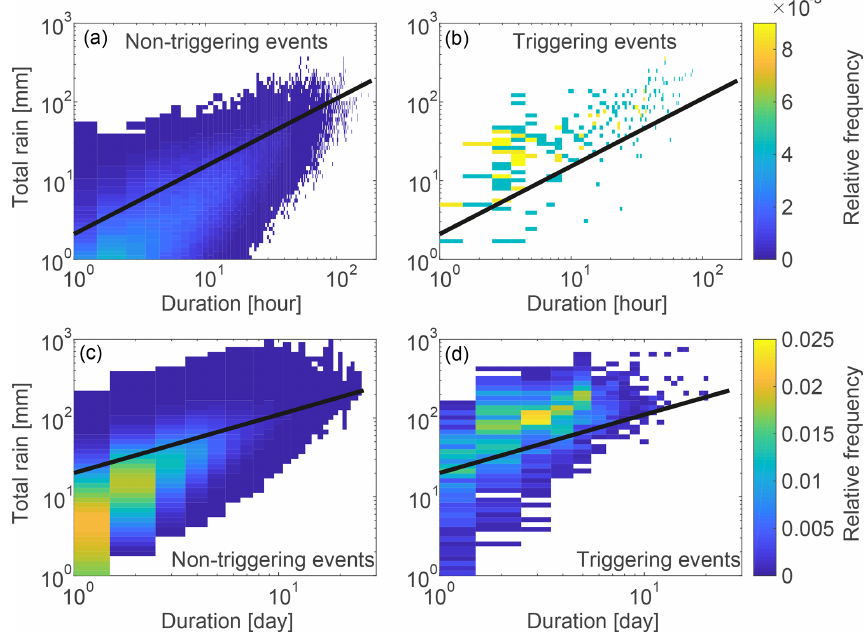
Figure 4. Total rainfall–duration (ED) plots with colour scale representing the relative frequency (a, c) of non-triggering and (b, d) of triggering events. The lines represent the best power law curve thresholds obtained by maximising TSS, (a, b) with hourly (RHIR) and (c, d) with daily (RDI) rainfall